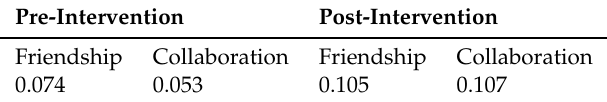
Table 3. Network Density.